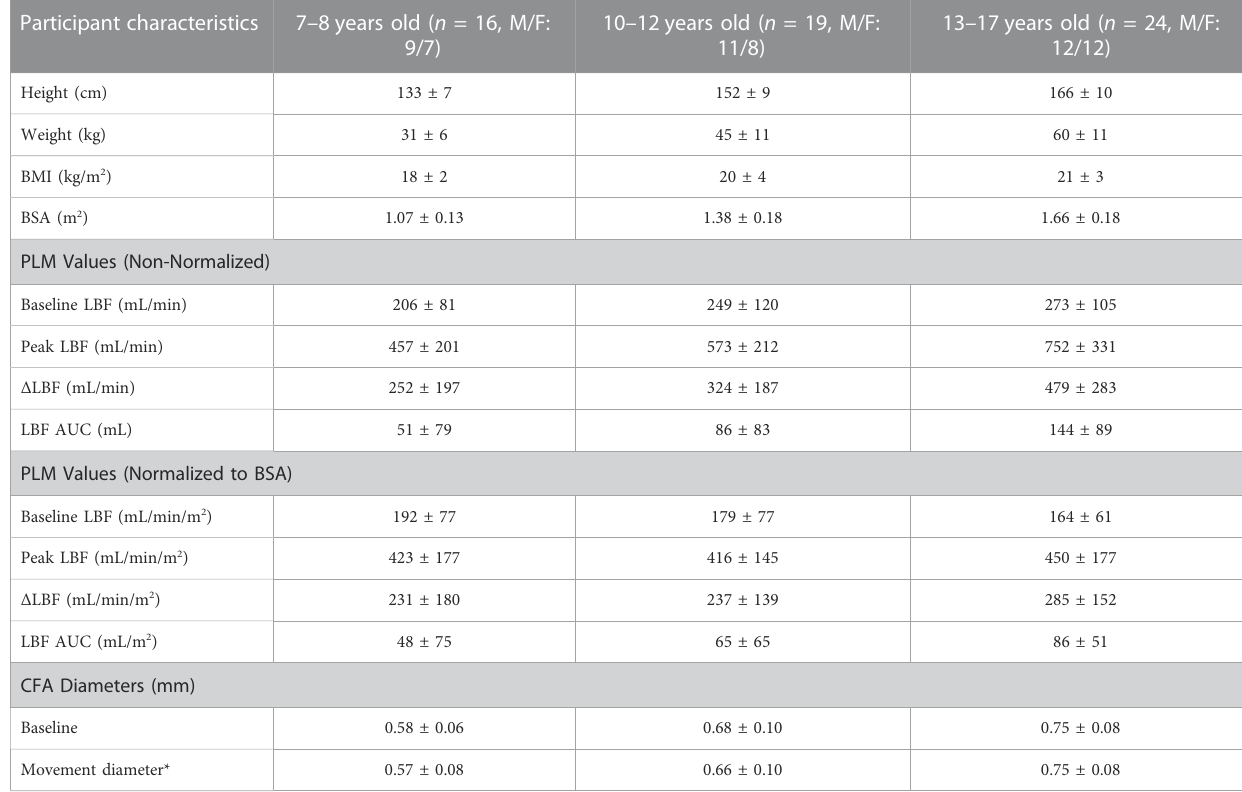
TABLE 1 Participant characteristics and PLM values in distinct pediatric age